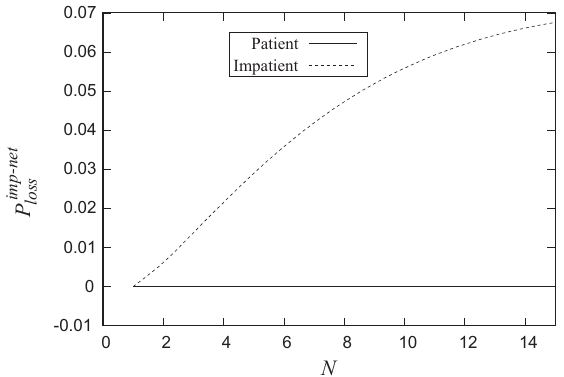
− net on the number N . loss